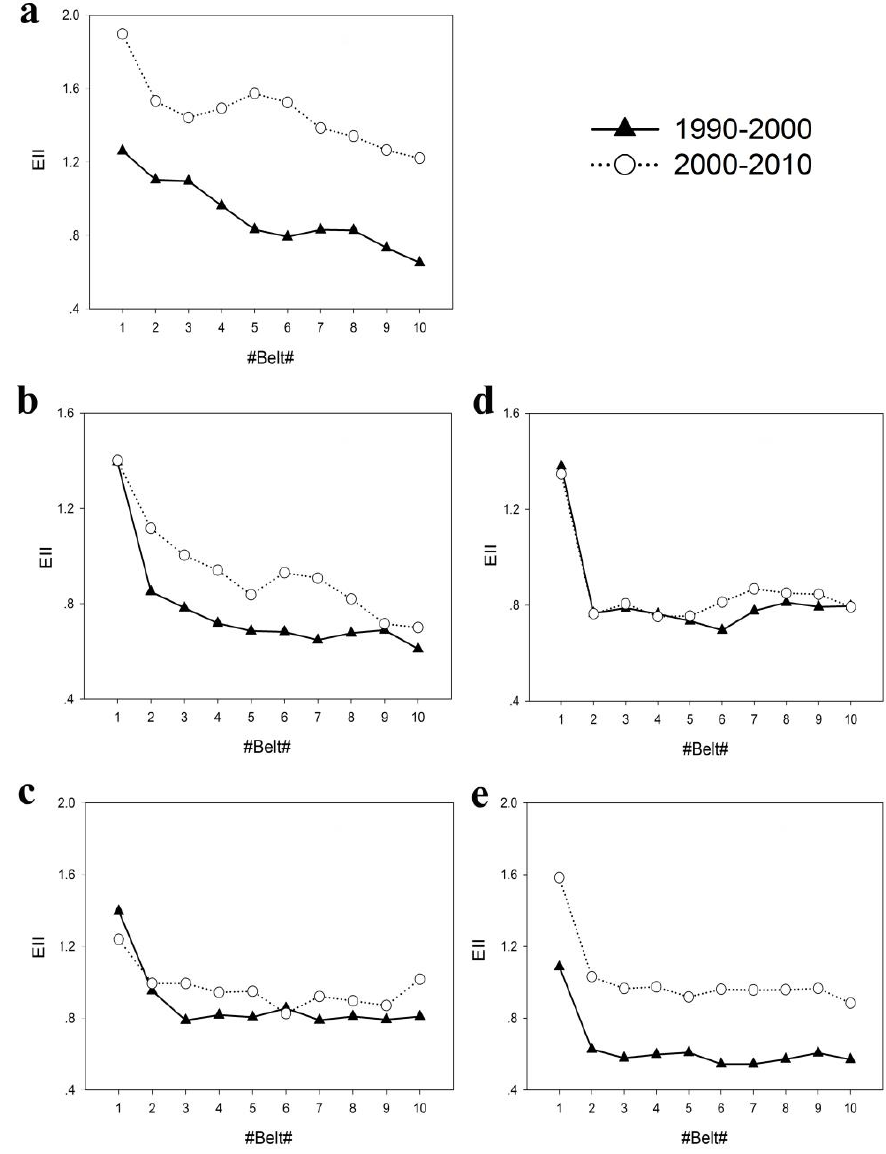
Figure 8. Buffer analysis of built-up land patterns for each period: ( a ) EII (expansion intensity index) changes of non-expressway opened before 1990; ( b ) EII changes of non-expressway opened between 1990 and 2000; ( c ) EII changes of non-expressway opened between 2000 and 2010; ( d ) EII changes of expressways opened between 1990 and 2000; and ( e ) EII changes of expressways opened between 2000 and 2010